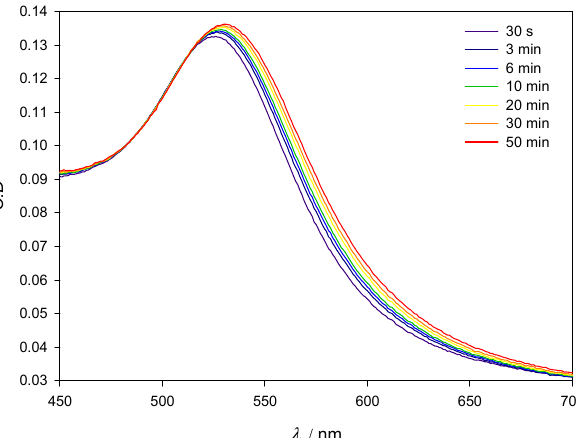
Figure 2. Experimental spectra of 10 nm AuNPs in the presence of Lys 3 × 10 − 4 M. [AuNPs] = 8.22 × 10 − 10 M.